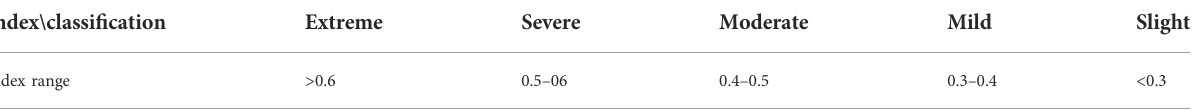
TABLE 5 Classi fi cation of the farmland system vulnerability of Sanmenxia